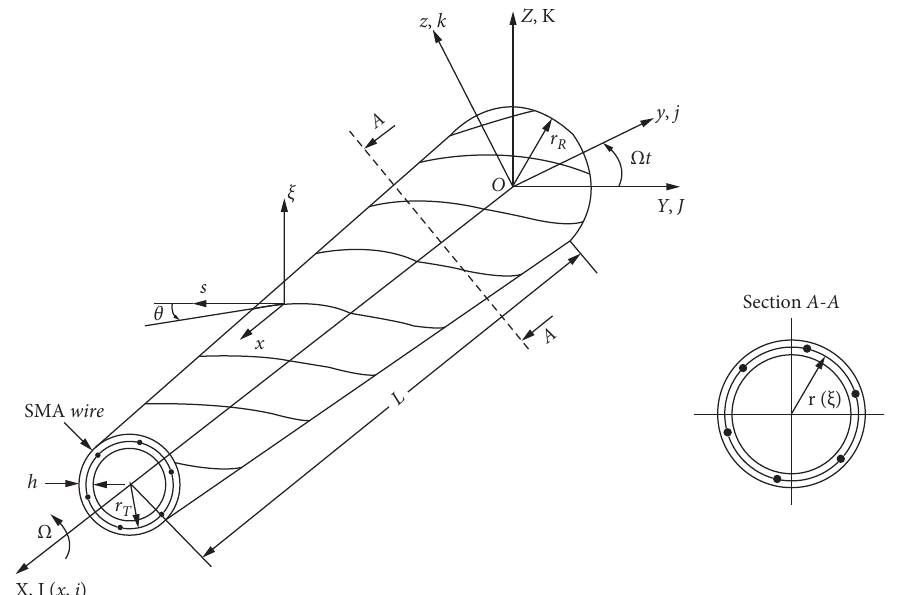
Figure 1: Coordinate systems and geometry of a tapered composite thin-walled rotating shaft with SMA